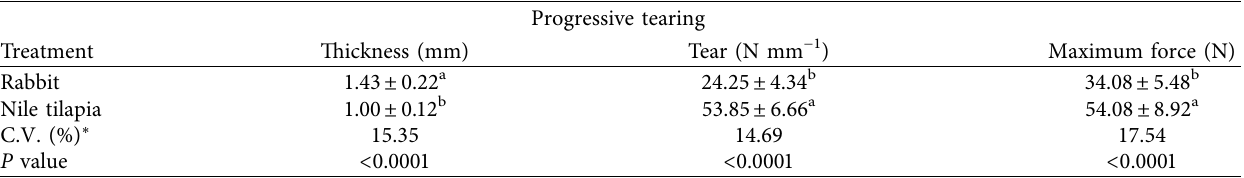
Means ± standard deviation; if there are different letters ( a,b ) there is a statistically significant difference through the F test ( P < 0.05); ∗ C.V. � coefficient of Variation. Table 2: Average tensile and stretching values of the Nile tilapia and rabbit leather specimens. Traction and